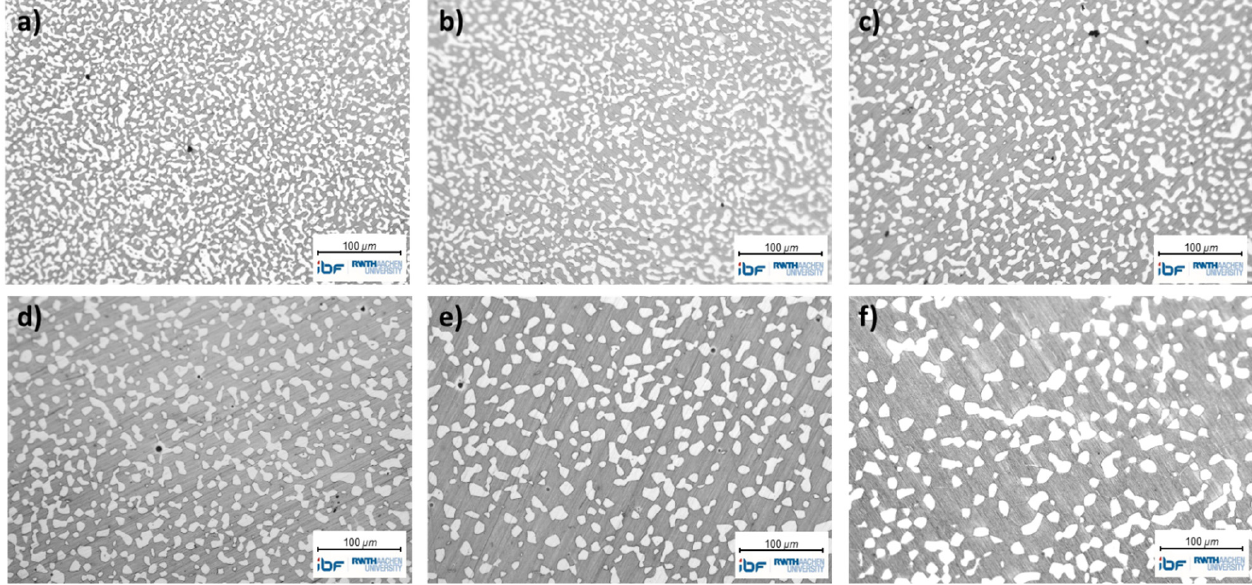
Figure 2. Microstructures after annealing at different temperatures for 1 h and quenching in water to achieve different ratios of ferrite and austenite volume fraction for ( a ) 1000 °C, ( b ) 1050 °C, ( c ) 1100 °C, ( d ) 1130 °C, ( e ) 1170 °C and ( f ) 1200 °C. Ferrite is depicted as grey and austenite as white.